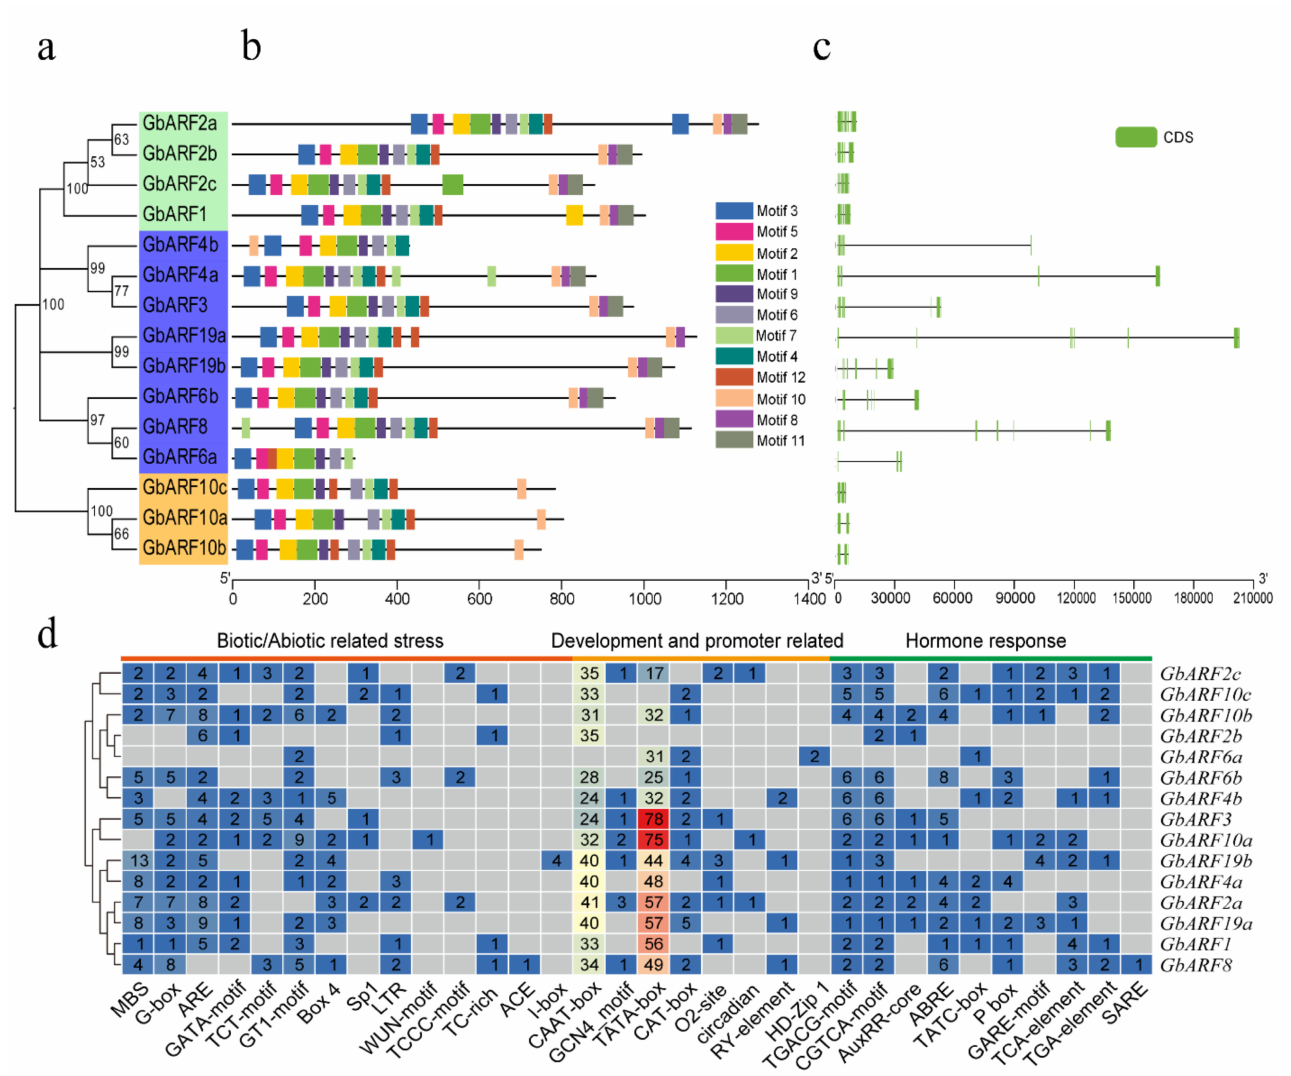
Figure 3. Phylogenetic tree, conserved motifs, gene structures, and regulatory elements of GbARF family. ( a ) Phylogenetic tree of GbARFs. ( b ) Conserved motifs in GbARF s. Different conserved motifs, numbers 1–12, are displayed in different colored boxes. ( c ) Exon-intron regions of GBARFs . ( d ) Numbers of cis-elements in GbARFs . Each gray box means that the gene does not contain following